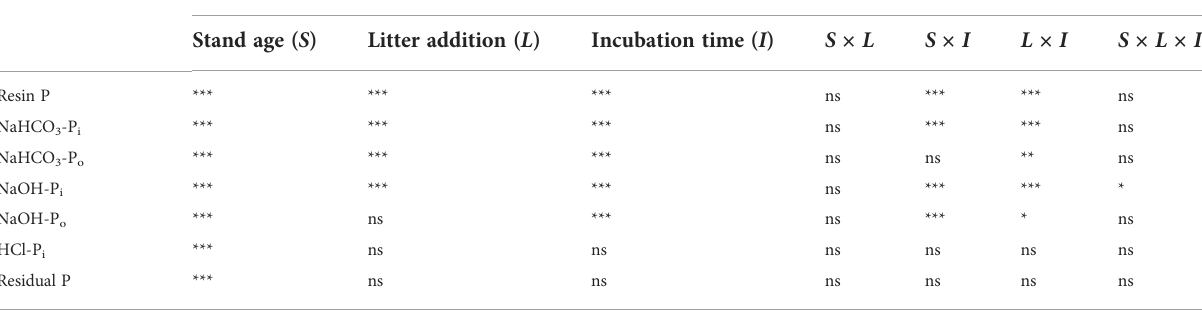
TABLE 3 Effects of stand age, litter addition, and incubation time on soil P in experiment 2. Soil P fractions Effects Stand age ( S ) Litter addition ( L ) Incubation time ( I